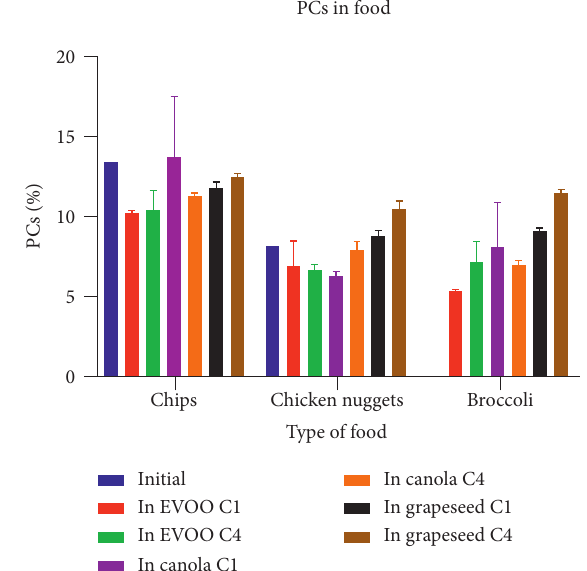
Figure 4: PCs in the food